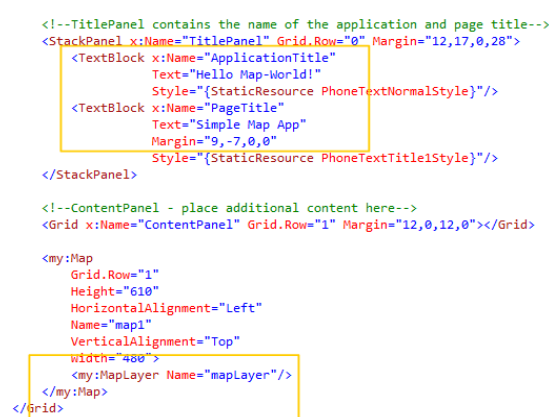
Modified XAML Code with Added Map Layer and Updated Names for Page and Application